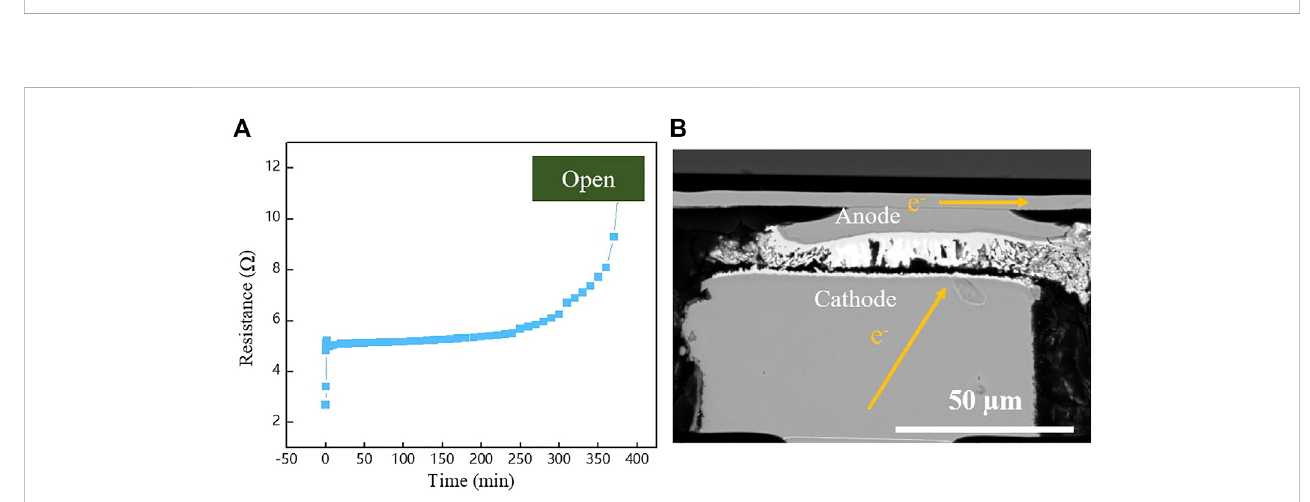
FIGURE 6 (A) The resistance evolution of thin IMC sample (B) the cross-sectional SEM image of failed thin IMC sample.